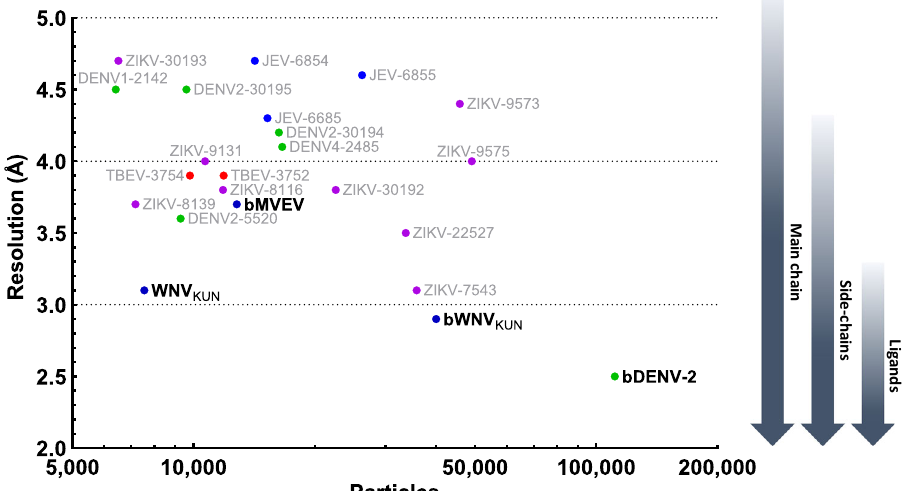
Fig. 7 Flavivirus reconstructions using cryo-EM. Cryo-EM reconstructions of fl aviviruses with a resolution higher than 5 Å are plotted against reported particle numbers on a logarithmic axis. Electron microscopy database IDs are indicated in grey next to each reconstruction. Structures are grouped as follows: DENV (green), ZIKV (magenta), JEV group (blue) and TBEV (red). The resolution range required to visualize structural details is illustrated on the right-hand side of the